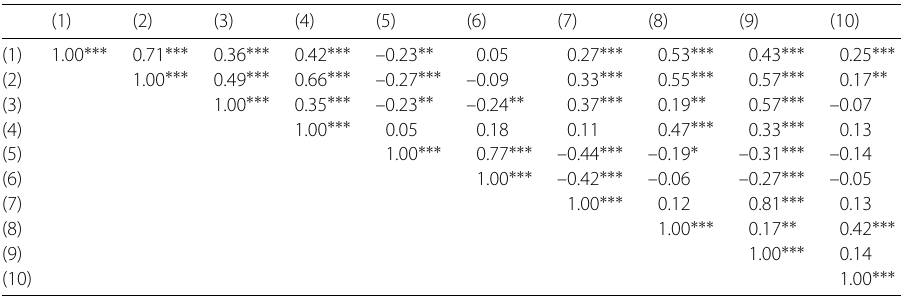
Table 3 Correlation table for LinkedIn, ILO and external development and gender inequality indicators